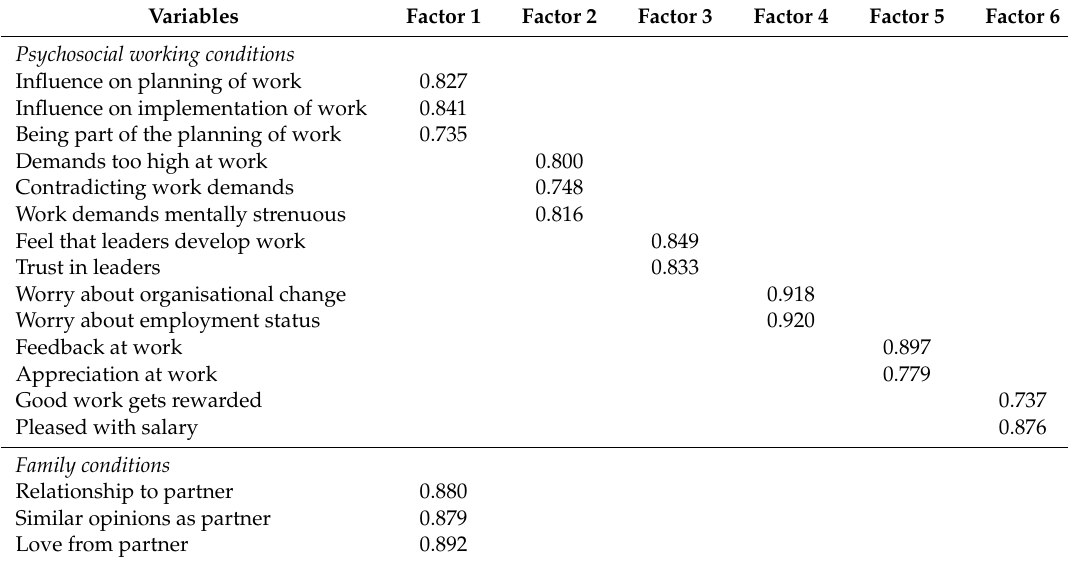
Table 1. Factor analysis of variables measuring psychosocial working conditions and family conditions (factor